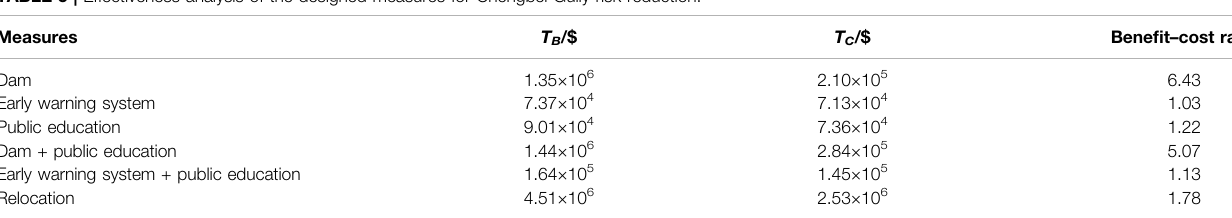
TABLE 5 | Effectiveness analysis of the designed measures for Chengbei Gully risk reduction.